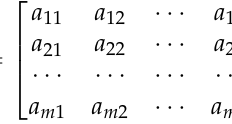
Figure 3. The basic steps of the AHP method.